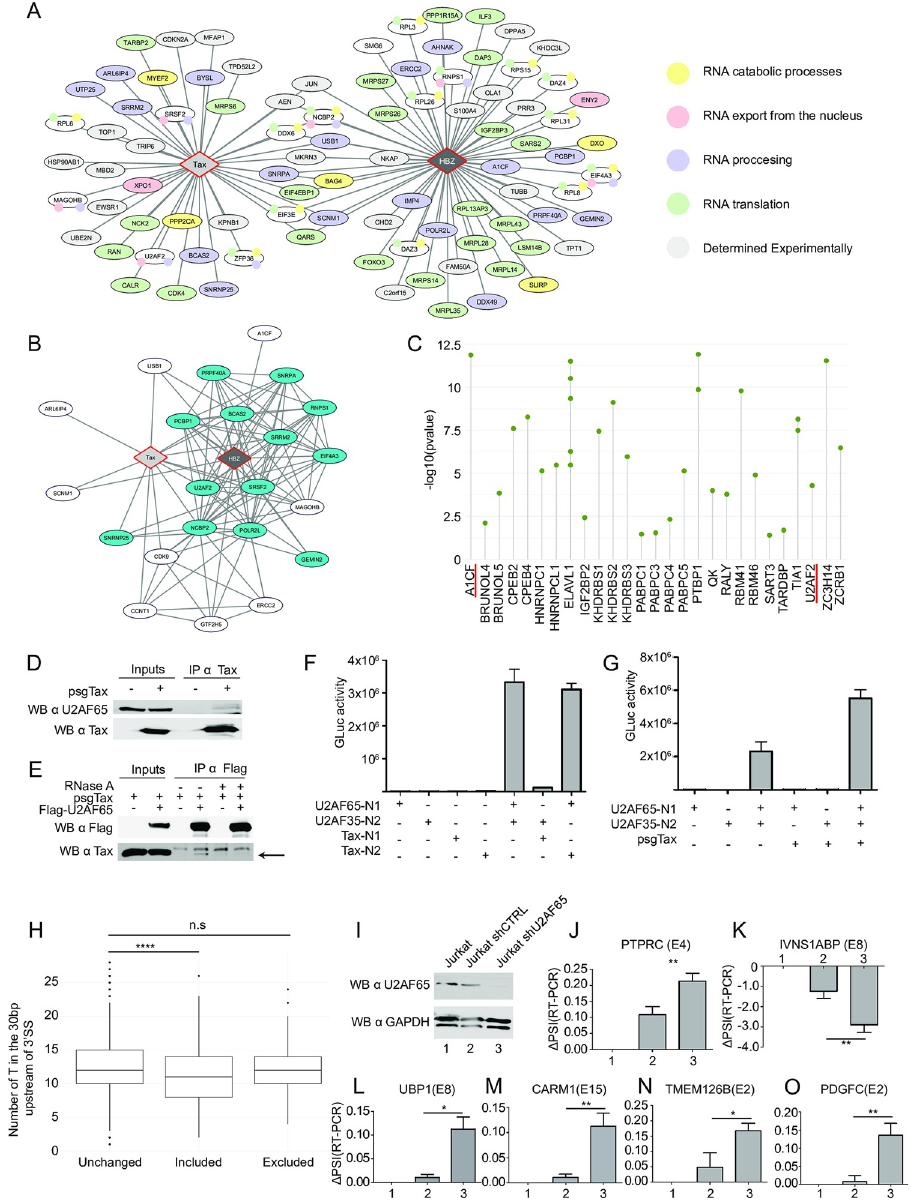
Fig 8. Identification of RNA splicing-specific roles for Tax and HBZ proteins. (A) Interactome of Tax and HBZ with PTRs, color-coded according to their GO categories. (B) Proteins involved in splicing (blue) are represented by wide edges. Thinner edges represent interactions between host proteins. (C) RNA-binding protein motif enrichment analysis of ASEs detected in ATLL samples. Sequences of regulated exons and part of their flanking introns were screened for RNA-binding motifs using AME from the MEME suite. Enriched motif(s) of RBPs with an adjusted p- value < 0.05 are shown. Known partners of Tax or HBZ are highlighted in red. (D) Co-Immunoprecipitation of Tax and U2AF65 in HEK293T cells. (E) Co-Immunoprecipitations of U2AF65 and Tax, in HEK293T cells treated or not with RNAse A. Detection of Tax is shown by an arrow. (F) GPCA assay for Tax and U2AF complex subunits. Y-axis shows average luciferase activities of three independent experiments. (G) GPCA assay, in HEK293T cells, for U2AF complex subunits under expression of Tax. Y-axis shows average luciferase activities of three independent experiments. (H) Number of T in the 30bp upstream of the 3’SS of alternatively spliced exons in Tax expressing cells. Medians are represented by a line. P = 4.044e-08. (I) Immunoblotting of U2AF65 in Jurkat cells knocked down for U2AF65 expression and control cells. (J-O) Δ PSI of AS exons in both conditions. Regulated exons are indicated in brackets. � = p-value < 0.05, �� = p-value < 0.01. See also S7 Fig.